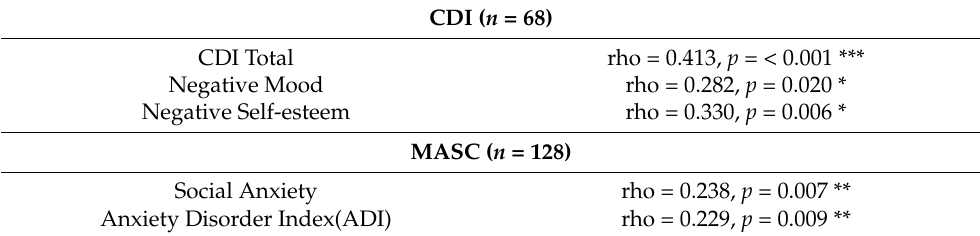
Table 4. Correlations between “length of stay” and CDI and MASC